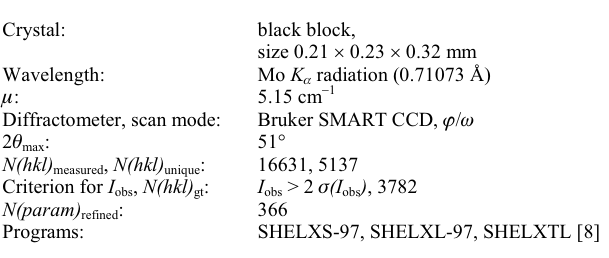
Table 1. Data collection and handling.